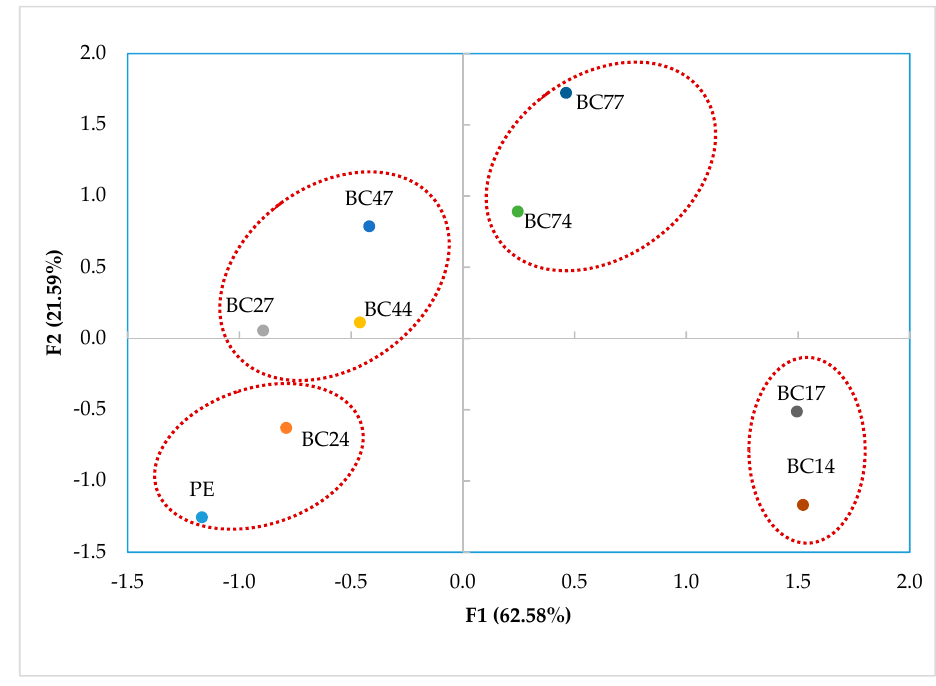
Figure 2. Plot of scores (trial) produced by PC1 and PC2 of the principal component analysis (PCA) analysis.